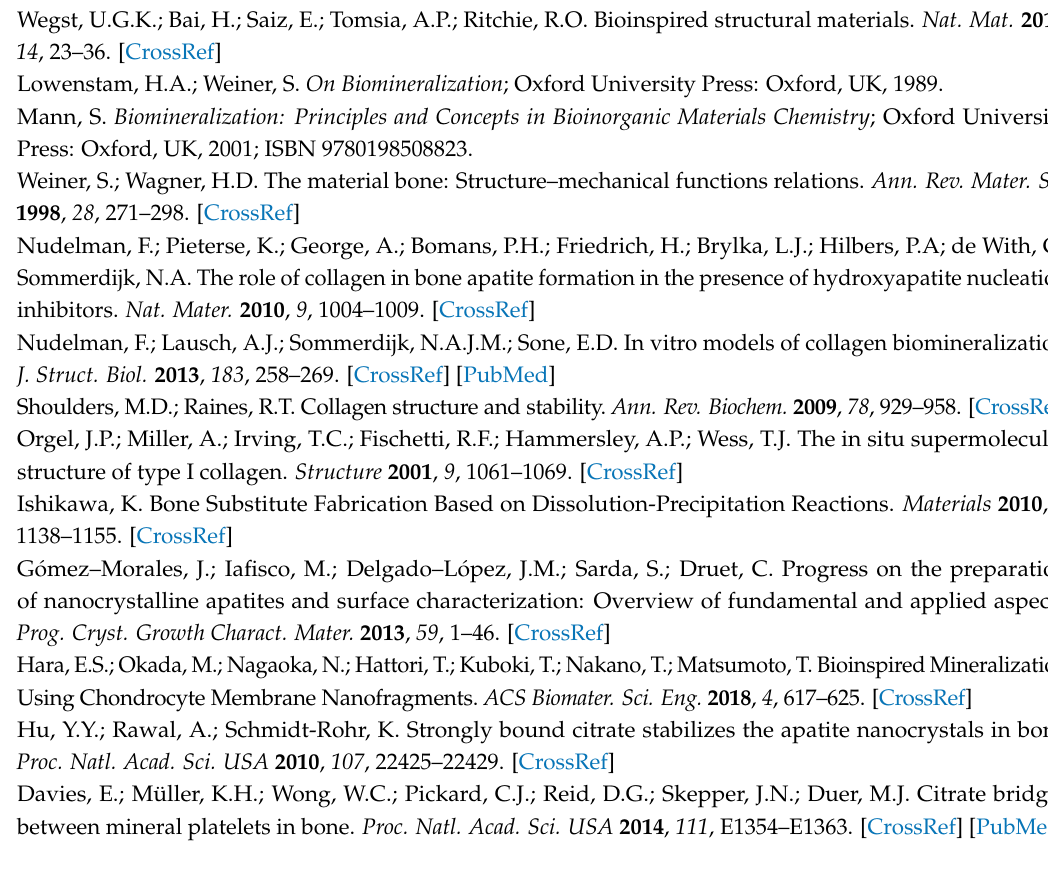
Figure S1: a) TGA curves of mineralized collagen fibrils (Col/Ap blank sample) and b) Eu–doped citrate coated mineralized collagen fibrils (sample Cit high